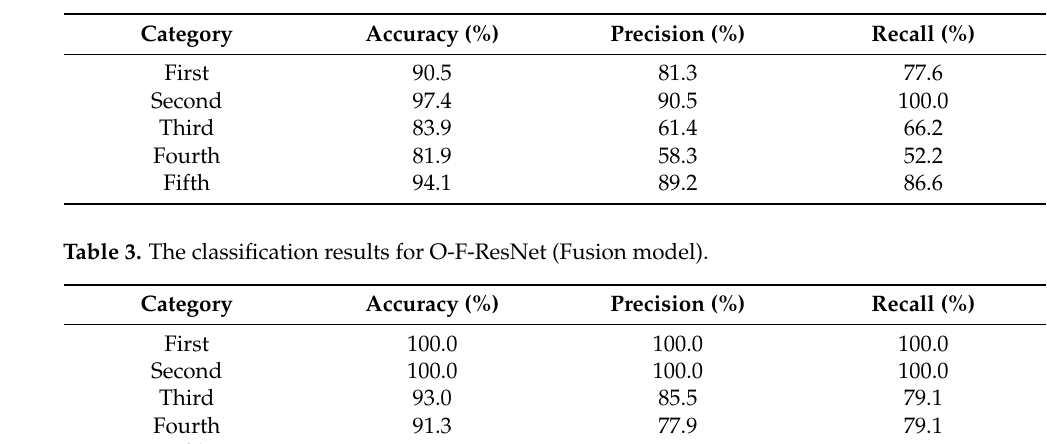
Table 2. The classification results for F-ResNet.